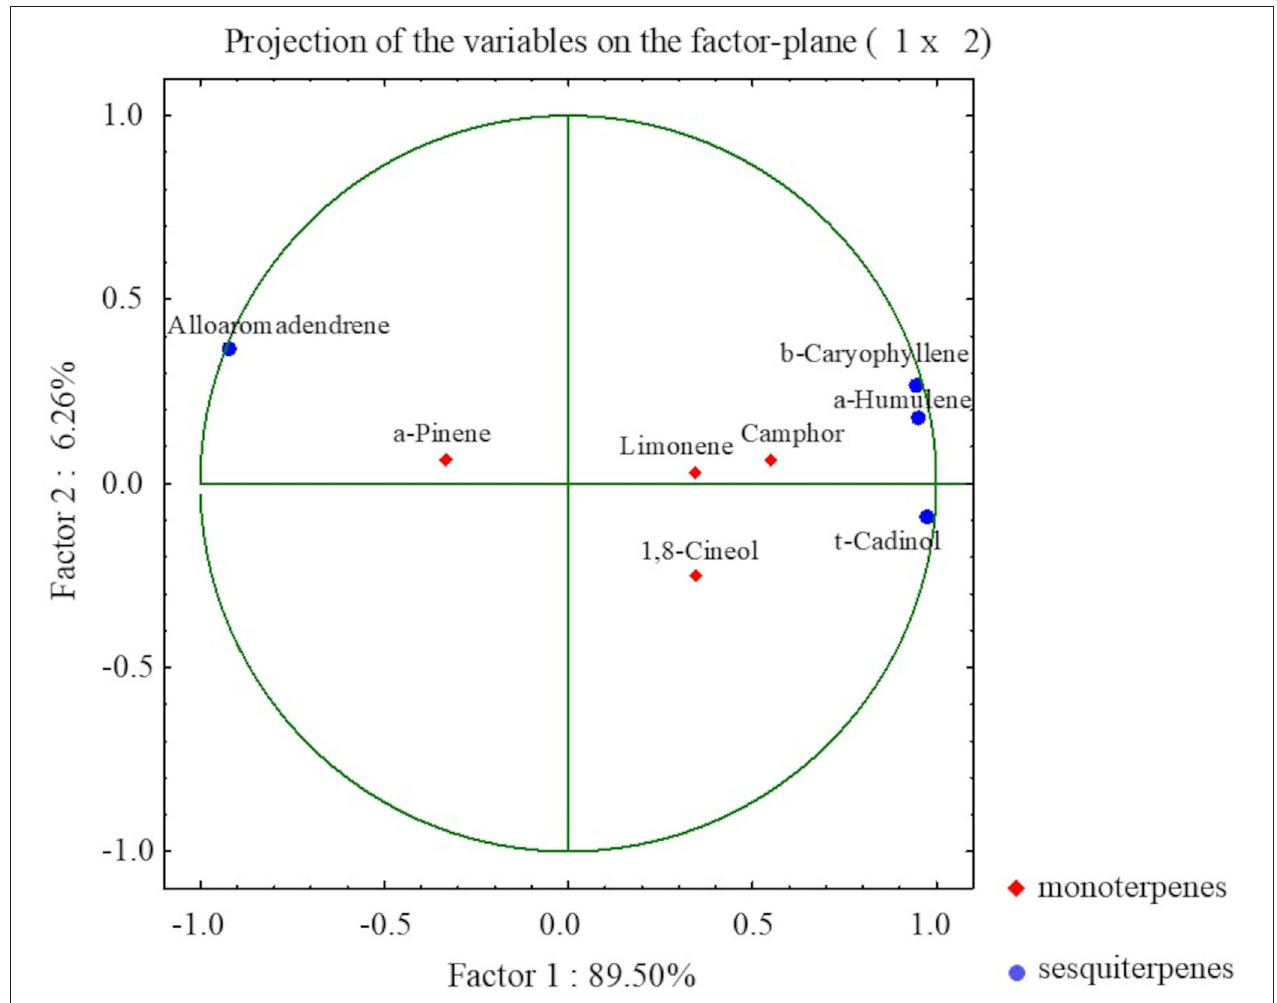
FIGURE 6 | The PCA presenting relationships between selected VOCs in S. yangii in vitro shoots in response to light intensity, temperature, and culture duration.